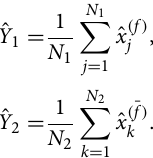
Figure 1. Post-selection dependence of the ratio factors β 1,2 in ( a ) and the individual averages and in the following figures the pre- and post-selection states are characterized by parameters B and θ (see main text for their